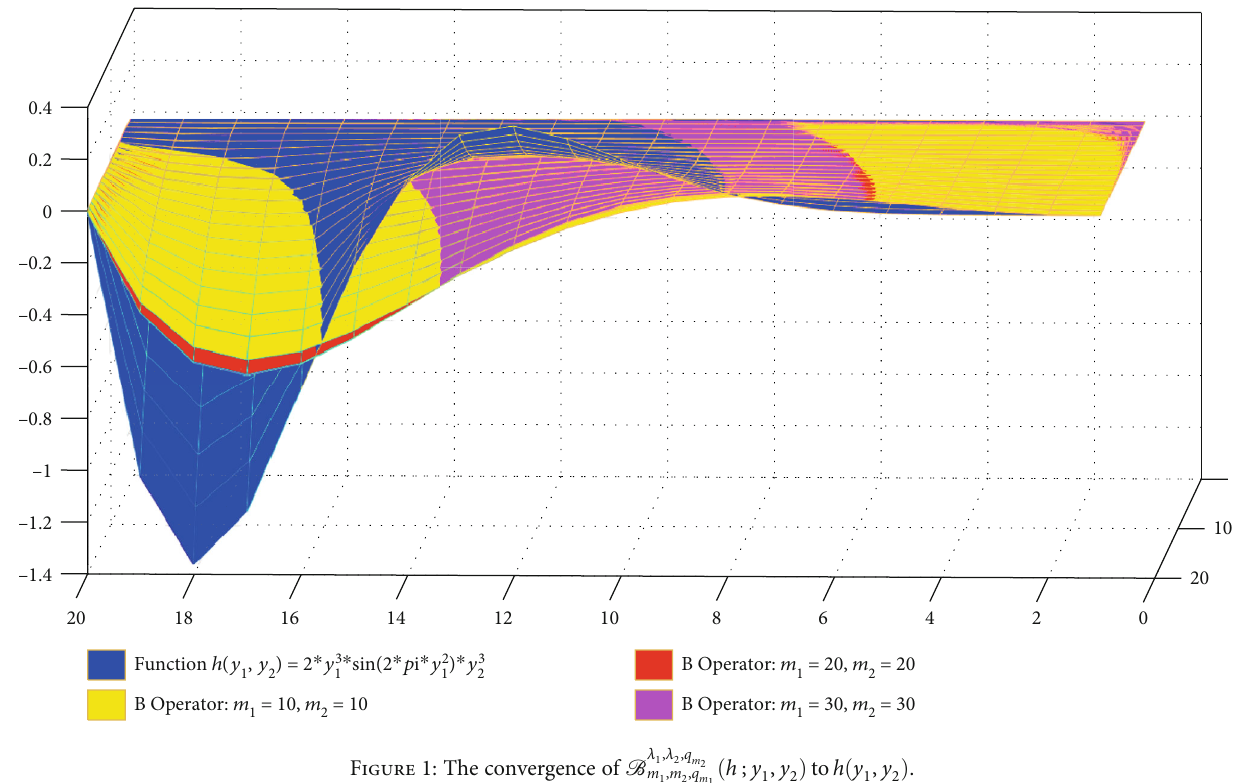
m 1 , m 2 , q m 1 ð h